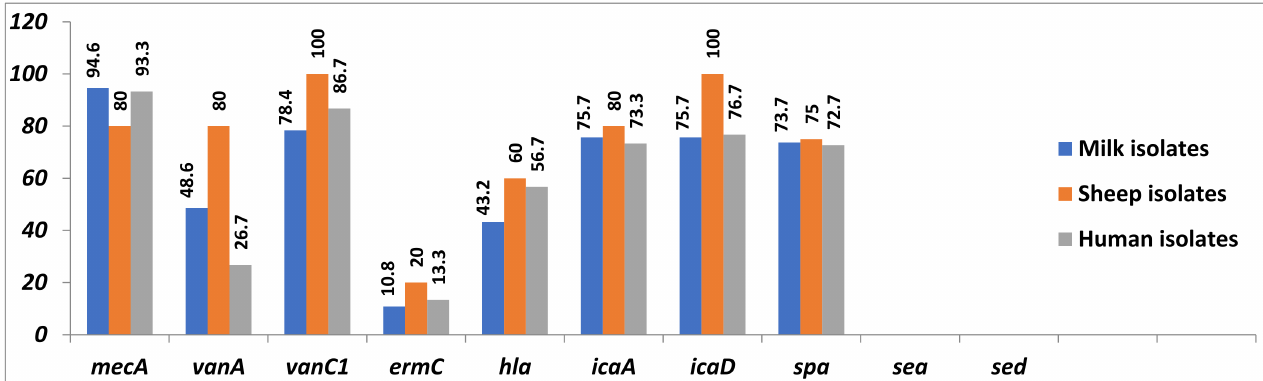
Figure 5. Prevalence and distribution of resistance- and virulence-associated genes in the examined Staphylococcus